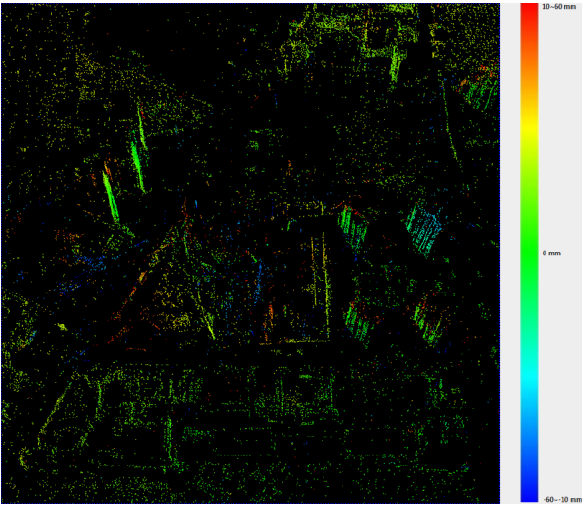
Figure 9. Surface motion velocity shown in different